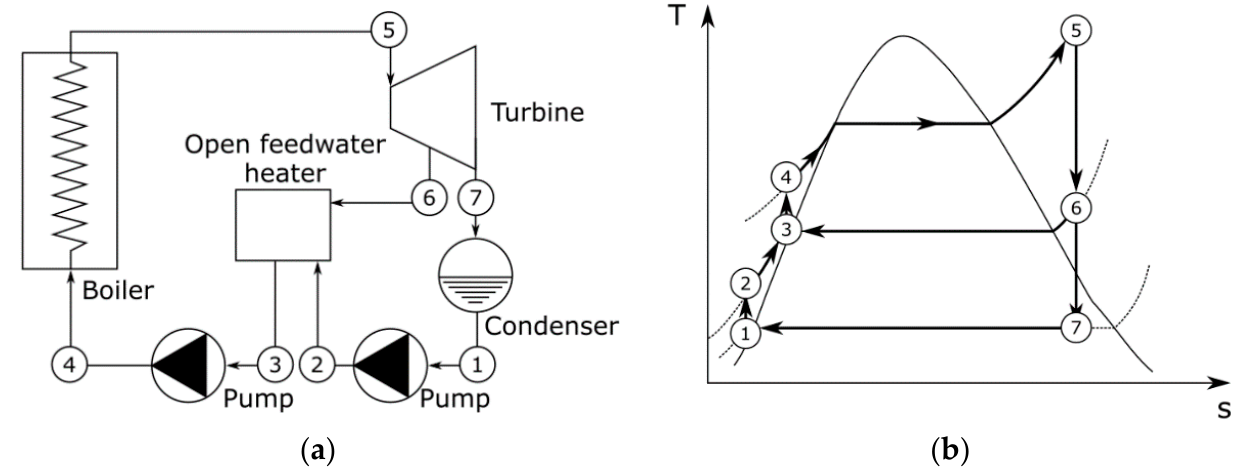
Figure 15. ( a ) Equipment and ( b ) T-s diagram of an ideal regenerative Rankine cycle with an open feedwater heater.